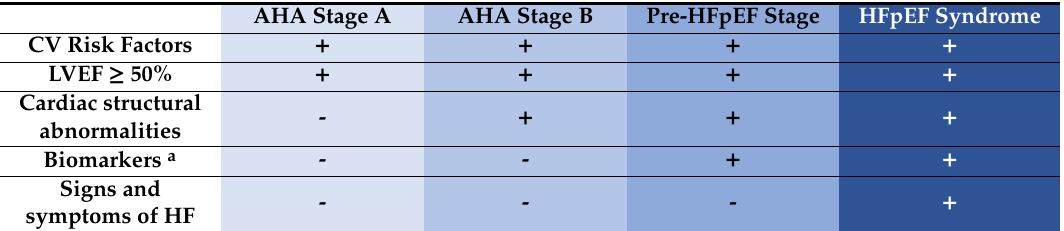
Table 1. Transitioning from Pre- heart failure with preserved ejection fraction (HFpEF) to HFpEF